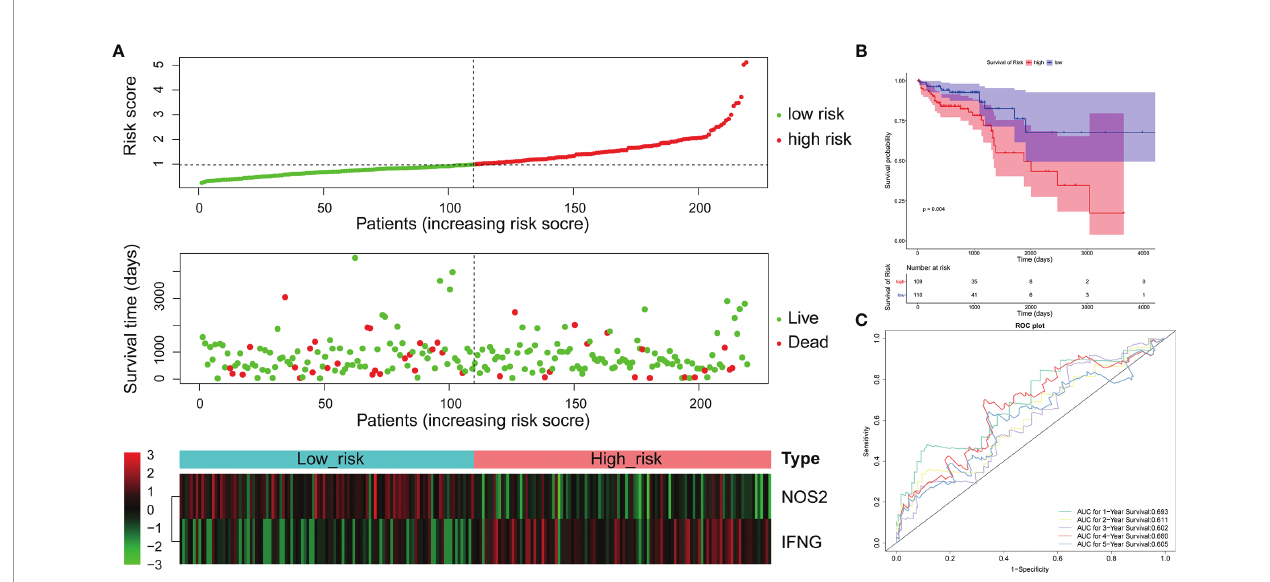
FIGURE 4 | Validation of the 2-gene signature in the whole TCGA-LCRC cohort. (A) Distribution of the risk score, the associated survival data, and the mRNA expression heat map in the whole TCGA-LCRC cohort. (B) Kaplan-Meier plot for OS based on risk score of the two gene-based signature of patients with LCRC in the whole TCGA-LCRC cohort. (C) AUC of time-dependent ROC curves in the whole TCGA-LCRC cohort.